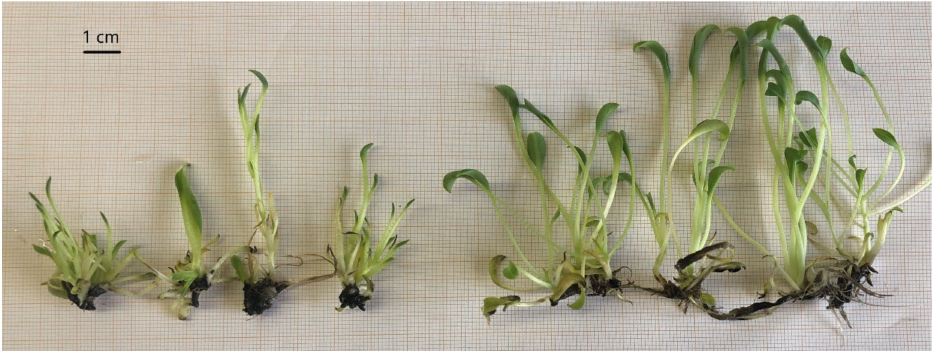
Figure 3. M. maritima rooted plants from the jars (left) and Plantform (right) after 4 weeks of culture.